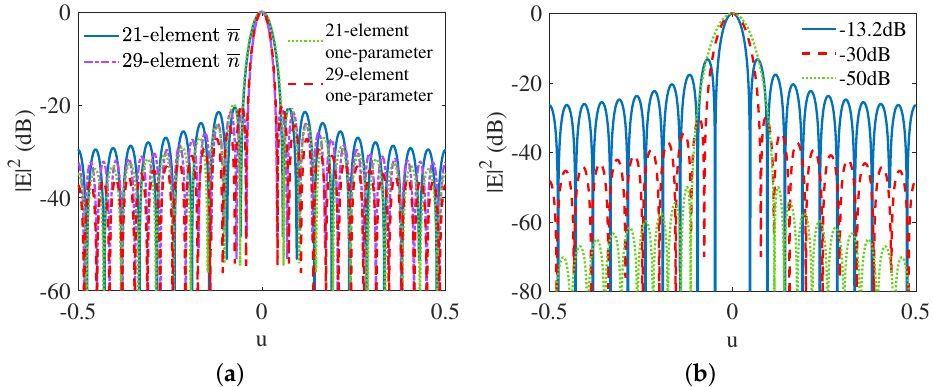
Figure 6. ( a ) Comparison of one-parameter Taylor-like patterns (green dotted line for N = 21 and red dashed line for N = 29) and n Taylor-like patterns (blue line for N = 21 and purple dot-dash line for N = 29) produced by Schelkunoff’s polynomial method with the same λ /2 element spacing. ( b ) One-parameter 21-element Taylor-like patterns where the first sidelobe level is − 13.2 dB (blue line), − 30 dB (red dashed line) and − 50 dB (green dotted line) respectively.